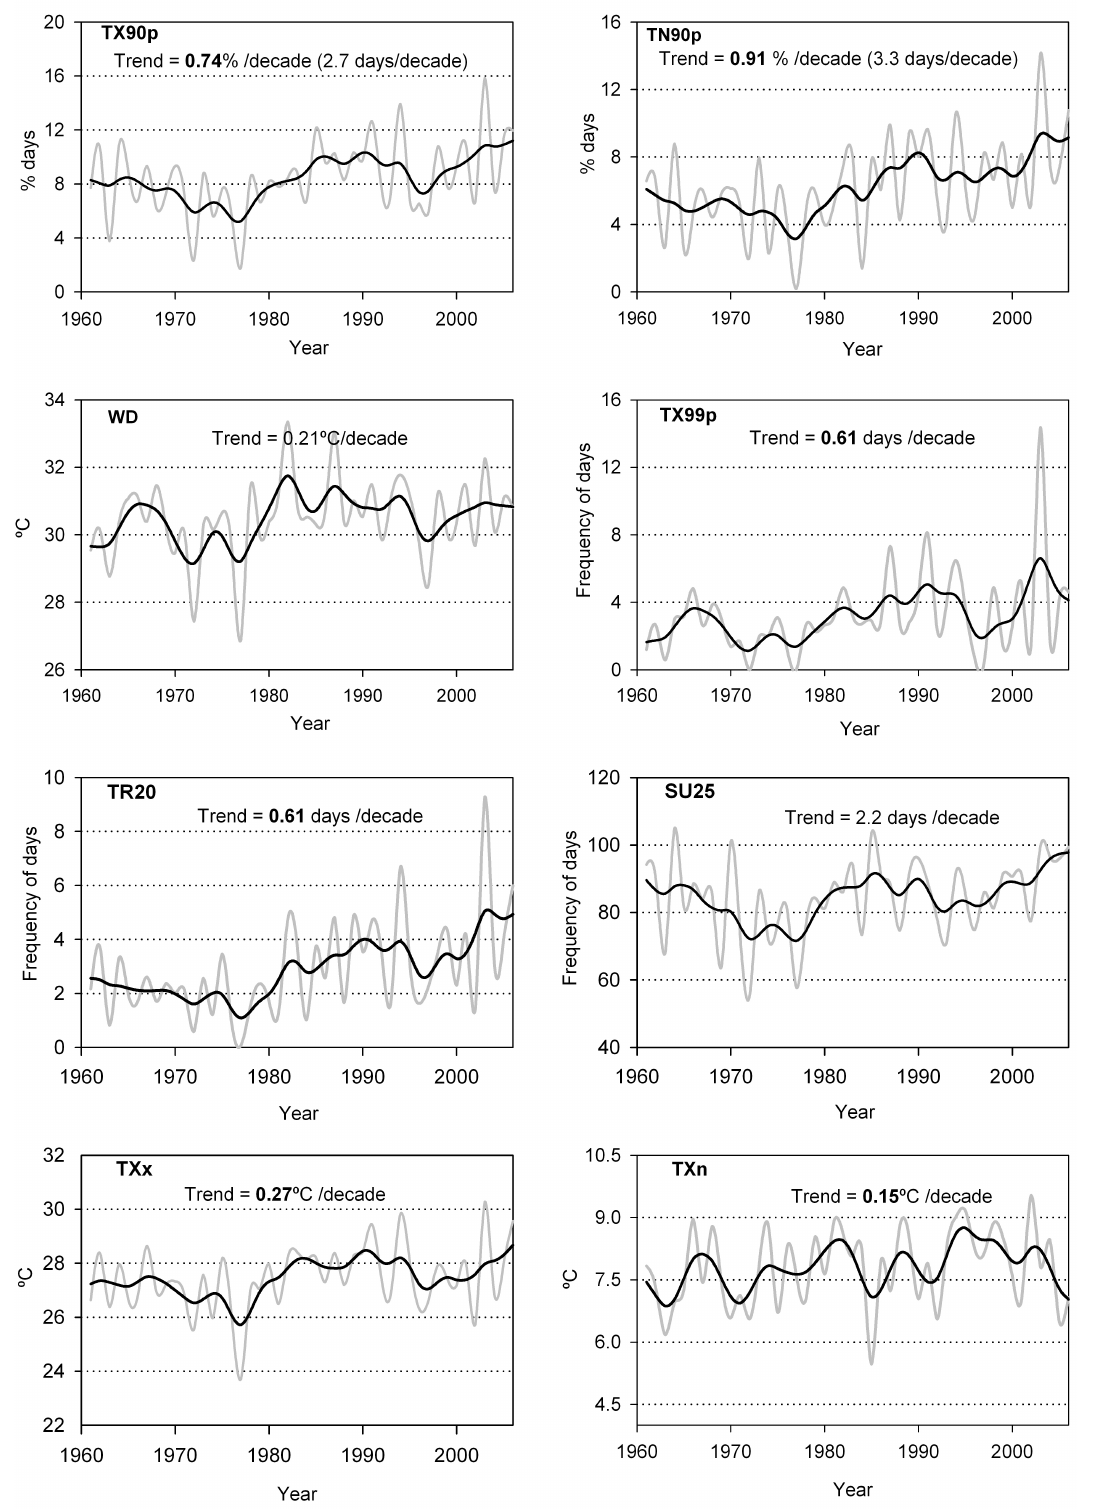
Fig. 7. Temporal evolution and trends in the regional series of hot extreme indices over the period 1960–2006. Only trend magnitudes given in bold numbers refer to significant trends (P-value < 0.05), and black lines represent a 7-yr running